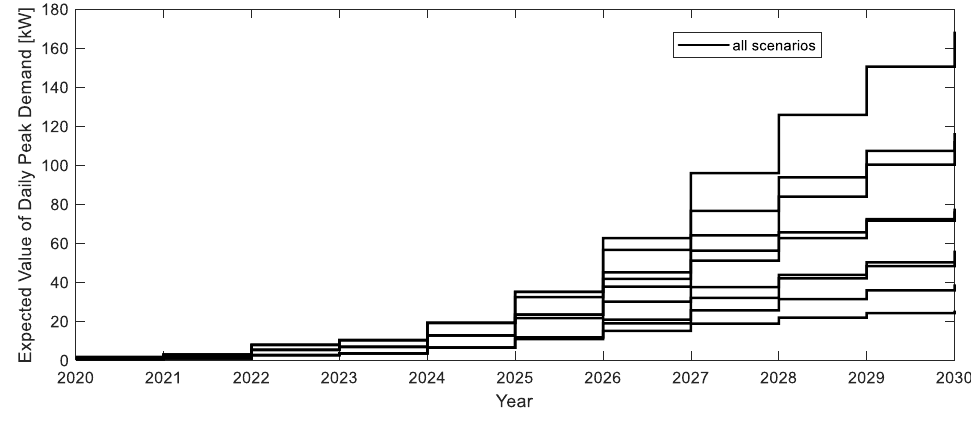
Figure 19. Energy and demand profile: for hypothetical average daily consumption of 1000 kWh/day and typical load curve for fast charging stations [30,31].